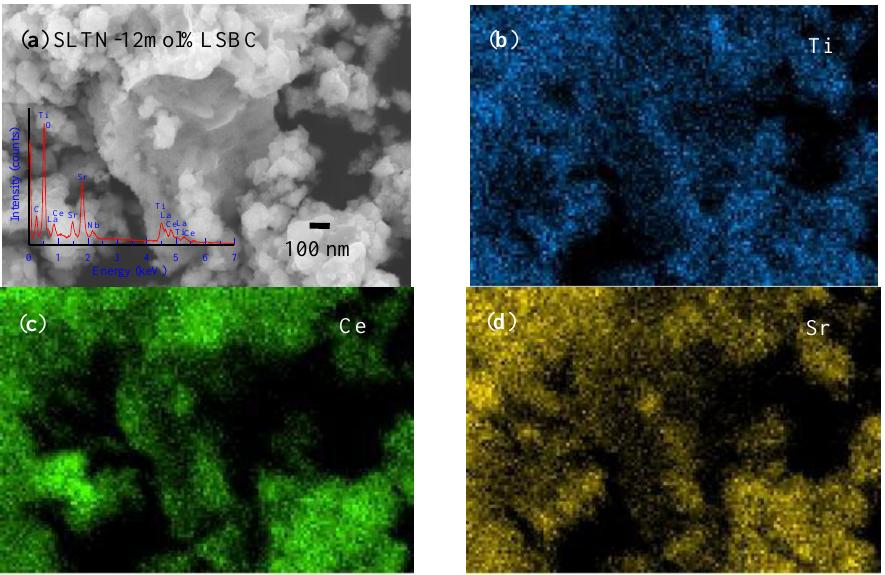
Figure 7. The FESEM images and EDS elemental analyses of the prepared core-shell anode powders, ( a ) FESEM image of SLTN-12 mol% LSBC, the inserted spectrum is its EDS analysis and the EDS elemental mappings on the SLTN-12 mol% LSBC, ( b ) Ti, ( c ) Ce and ( d ) Sr [56].